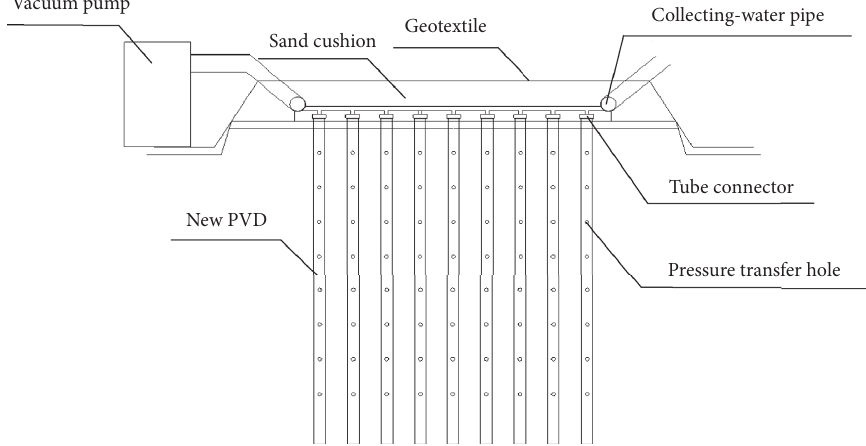
Figure 2: Vacuum preloading method with pumping and discharging.